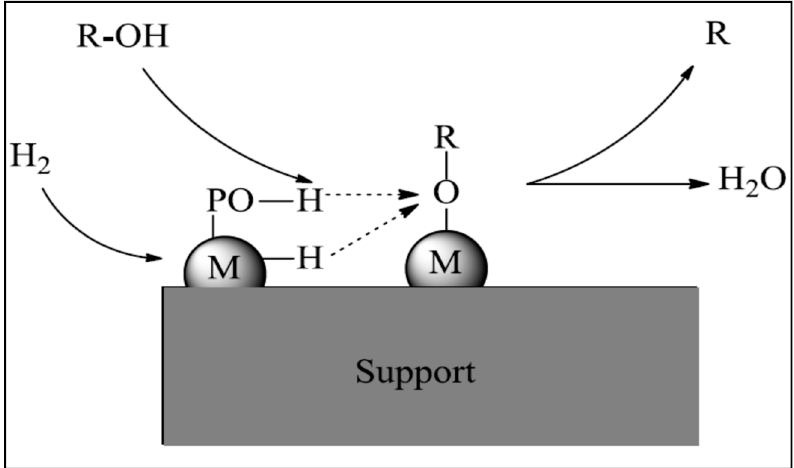
Figure 3. Proposed hydrodeoxygenation (HDO) mechanism using supported transition metal phosphides. Reproduced with permission from the authors of [77].